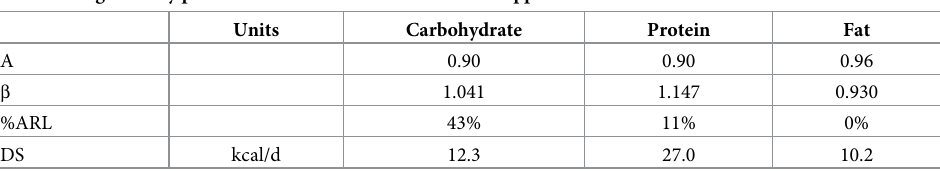
Table 4. Digestibility parameters for macronutrients for the upper GI.